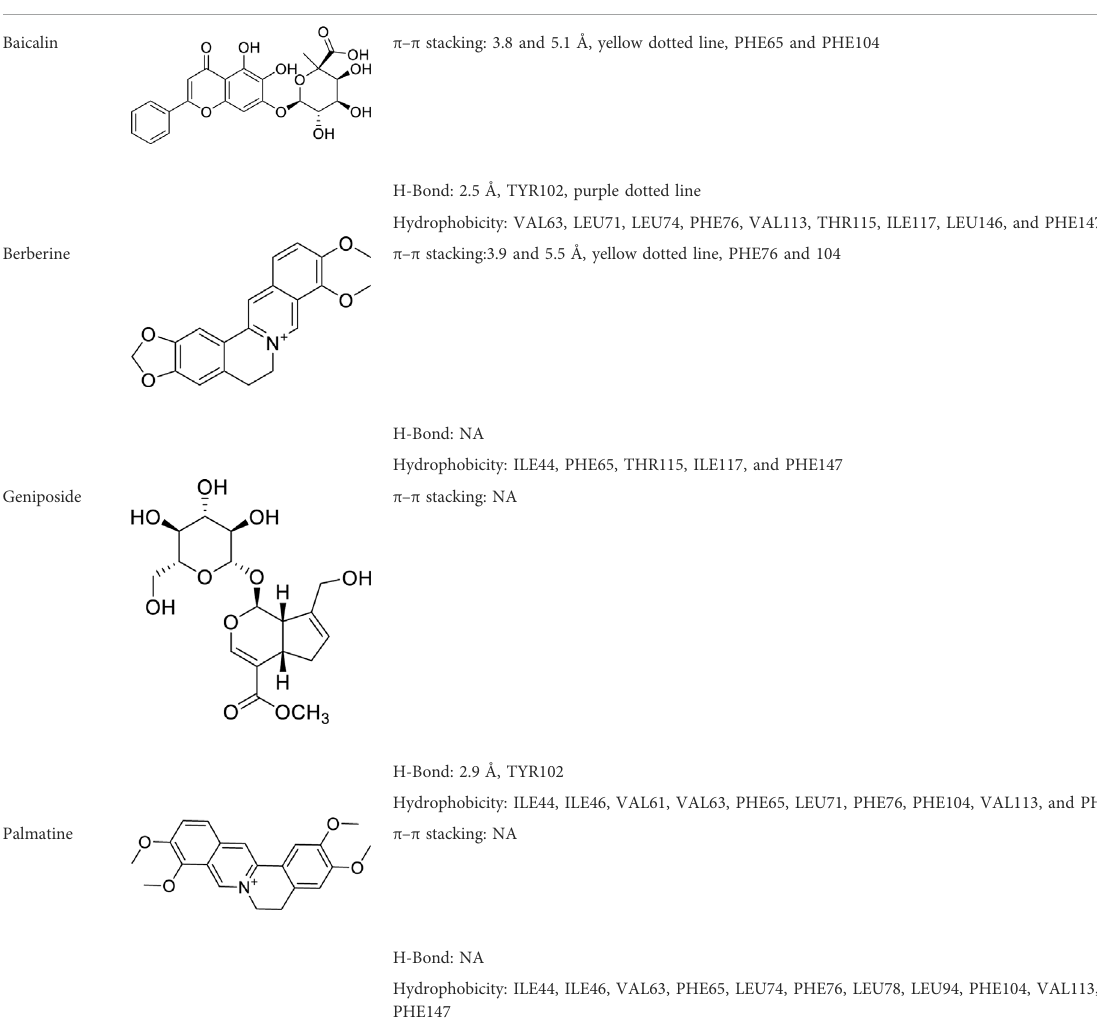
TABLE 2 Docking of the effective components to MD-2 (PDB code: 3vq2). Compound